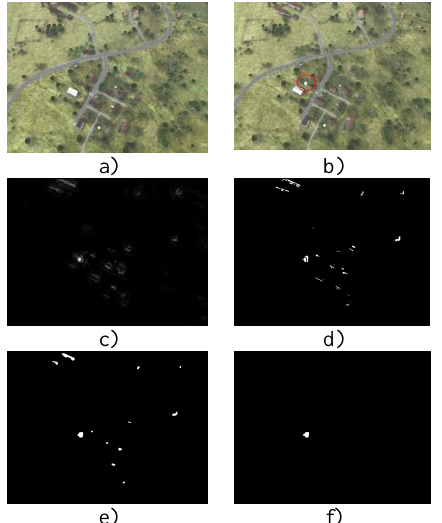
Figure 2. Stages of change detection pipeline: a) reference image; b) test image; c) morphological difference map (MDM); d) binarized MDM; e) change proposals (regions of filtered binarized MDM); f) accepted change